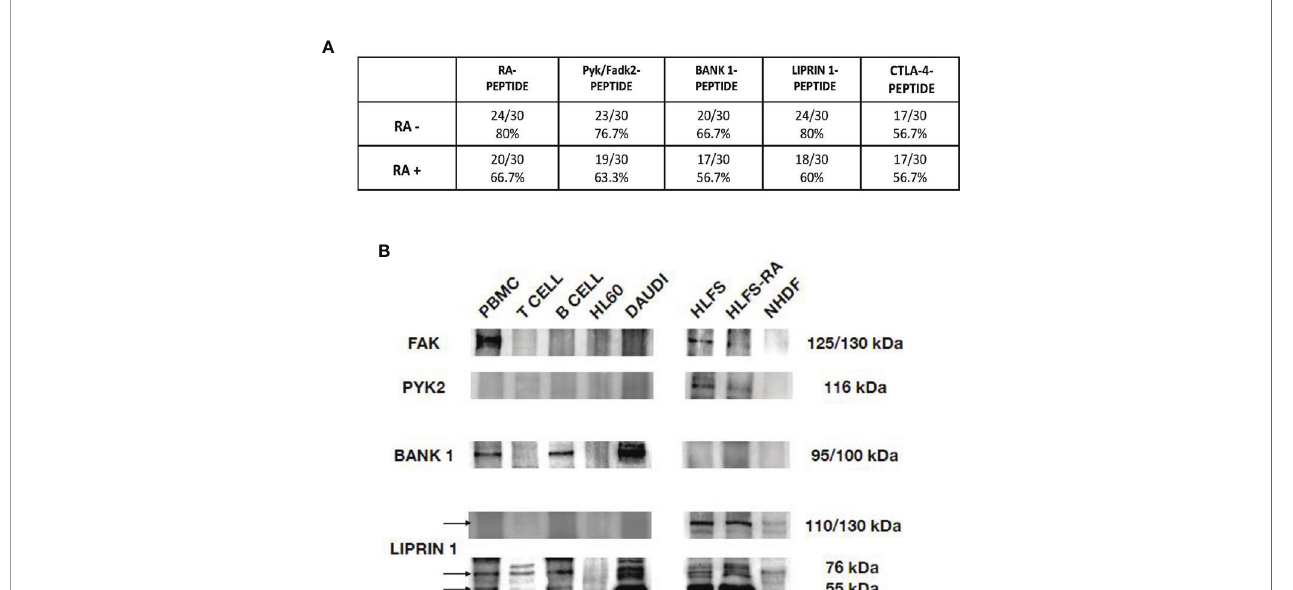
FIGURE 4 | Peptides cross-reaction of RA patients ’ sera and recognition of auto-antigens by puri fi ed anti-RA-peptide Abs. (A) Frequency of the direct binding of seronegative and seropositive patients ’ sera to RA, Pyk/Fadk2, Bank-1, Liprin-1 and CTLA-4 peptides evaluated by ELISA assays. No binding was observed using serum IgG of healthy donors. The arbitrary cutoff of 0.090 was used. (B) Immunoblot analysis of cell lysates, after immunoprecipitation with af fi nity puri fi ed anti-RA- peptide antibodies detected with commercial antibodies: mouse polyclonal antibodies directed against PYK2 or rabbit polyclonal antibodies directed against BANK, or rabbit polyclonal antibodies directed against Liprin. PBMCs, T or B cells were obtained by a normal healthy donor; HL60 (Human promyelocytic leukemia) and DAUDI (Burkitt lymphoma cell) lines were used as controls; HLFS (Normal Human Fibroblast-Like Synoviocytes) and HLFS-RA (Human Fibroblast-Like Synoviocytes: Rheumatoid Arthritis) and NHDF (Normal human dermal fi broblast) were commercially